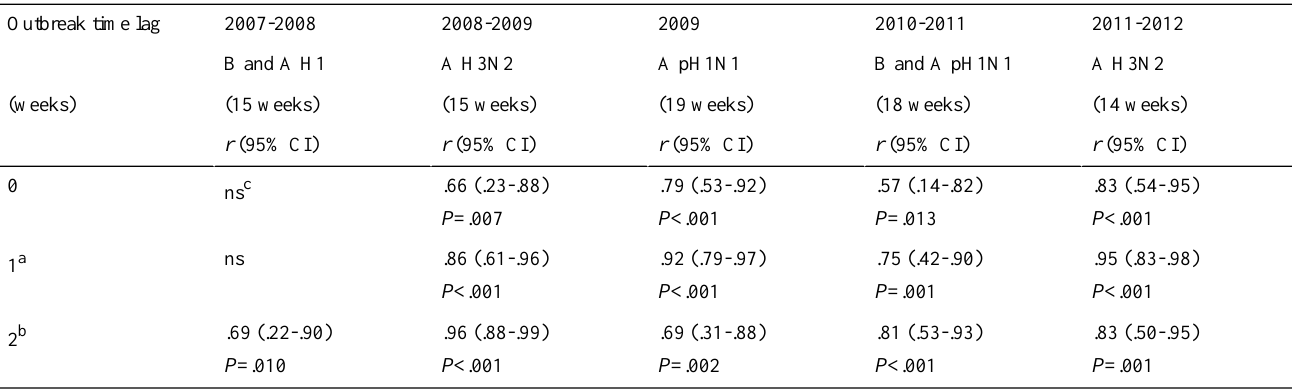
Table 2. Associations on a weekly basis between GFT data and influenza case data displayed by the correlation coefficient r (95% CI), for the five influenza outbreaks observed in Östergötland county, Sweden, during the study period 2007-2012.